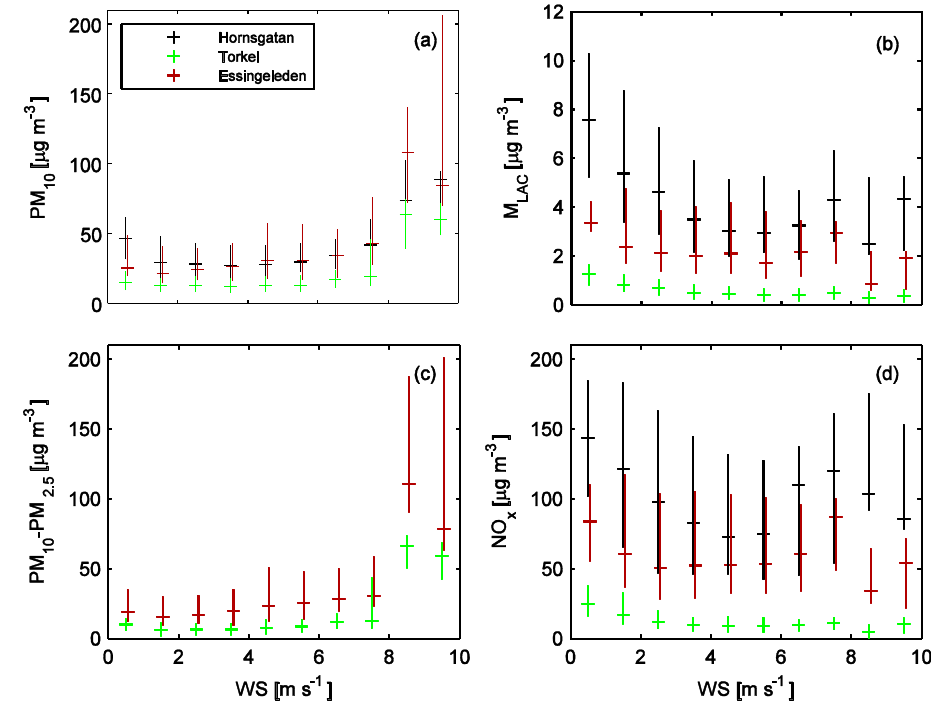
Fig. 8 Fig. 8. Weed speed dependence of PM 10 (a) , M LAC (b) , PM 10 –PM 2 . 5 (c) , and NO x (d) for the urban stations in the period 20 April–5 July 2006 (excluding the LRT event). Median and interquartile range concentrations are